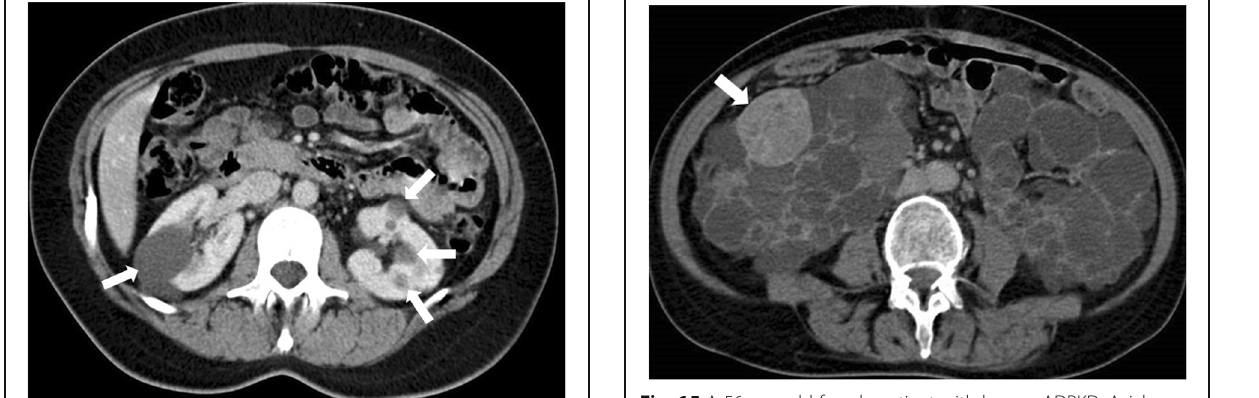
Fig. 15 A 56-year-old female patient with known ADPKD. Axial plane postcontrast CT image shows enlarged kidneys with innumerable cysts and a solid mass in the right kidney (arrow). Histopathological examination after surgery revealed papillary type renal cell